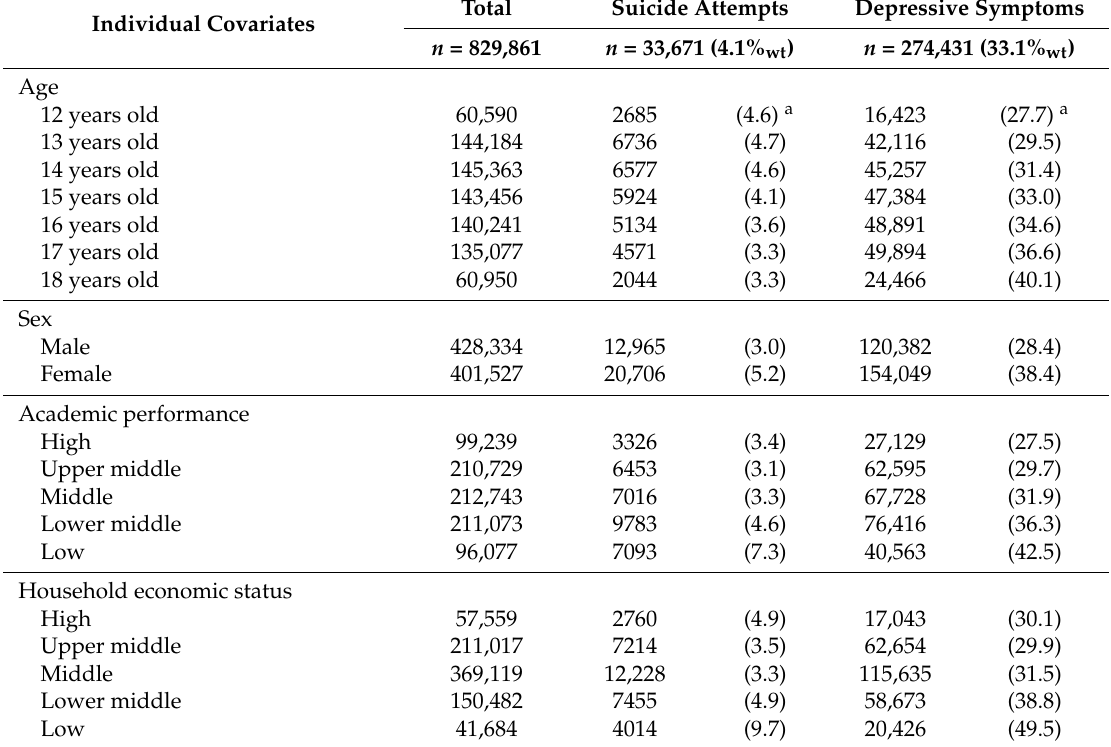
Figure 2. Trends in proportions of suicide attempts and depressive symptoms among Korean middle- and high-school students. Table 1. Characteristics of adolescents attending middle- and high-school in 2005-2016 Korea Youth Risk Behavior Web-based Survey (KYRBS).